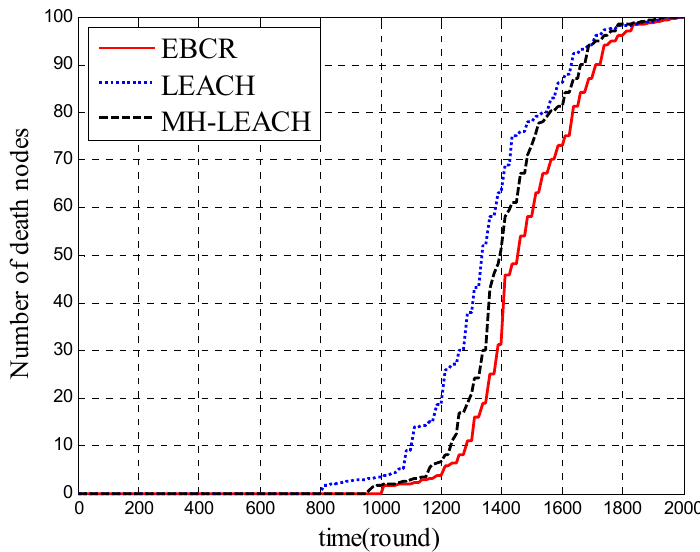
Figure 9. Comparison of the number of dead nodes.